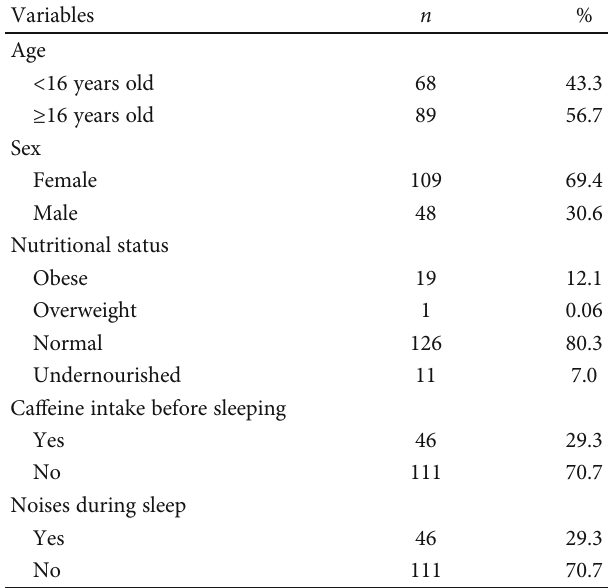
Table 1: Characteristics of study participants ( n = 157